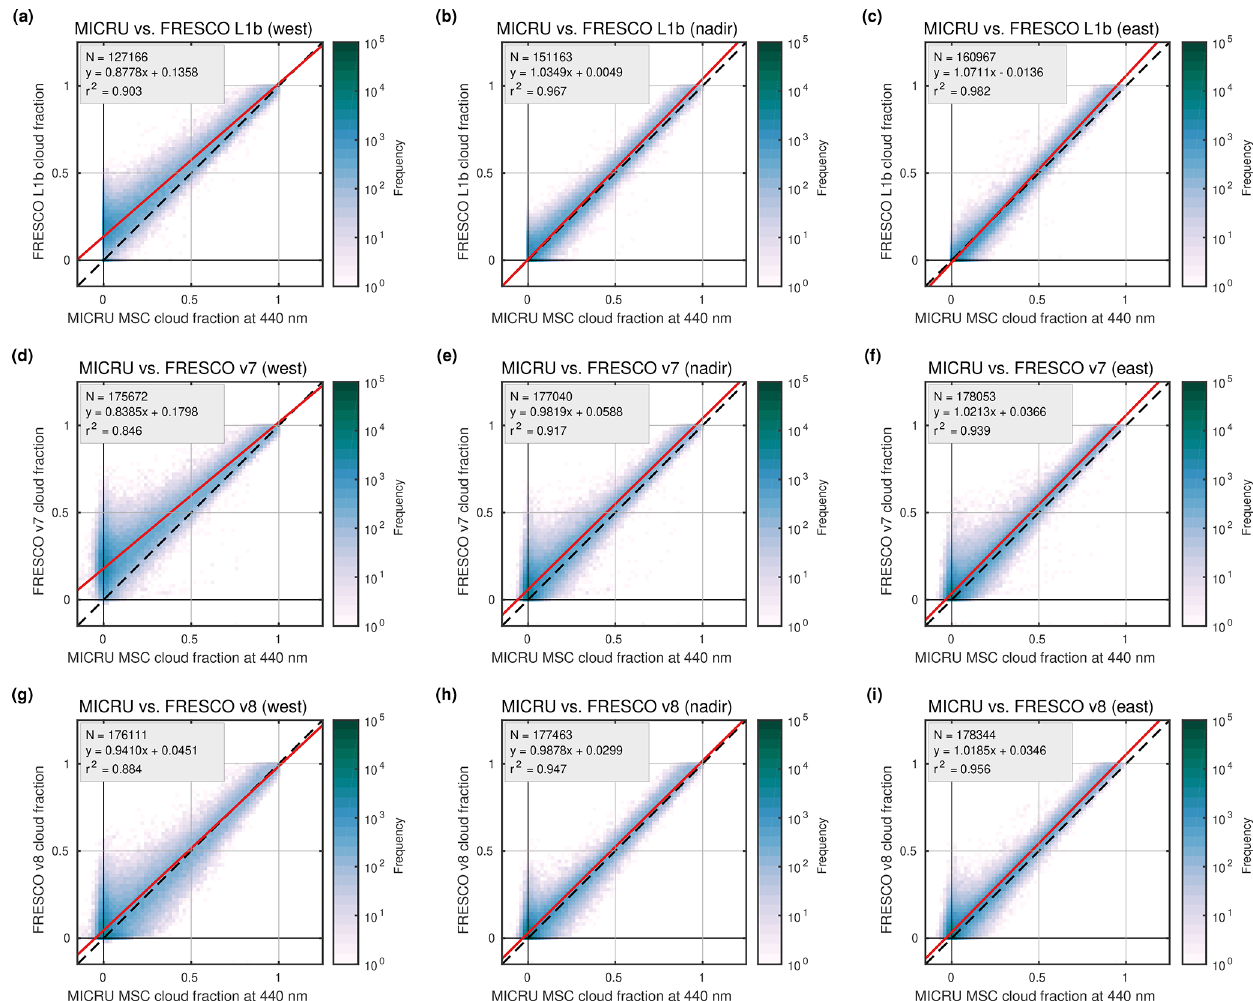
Figure 22. Viewing angle dependence of the comparison between MICRU at 440nm and three different FRESCO versions over land. Same data as Fig. 21a, c, and e,